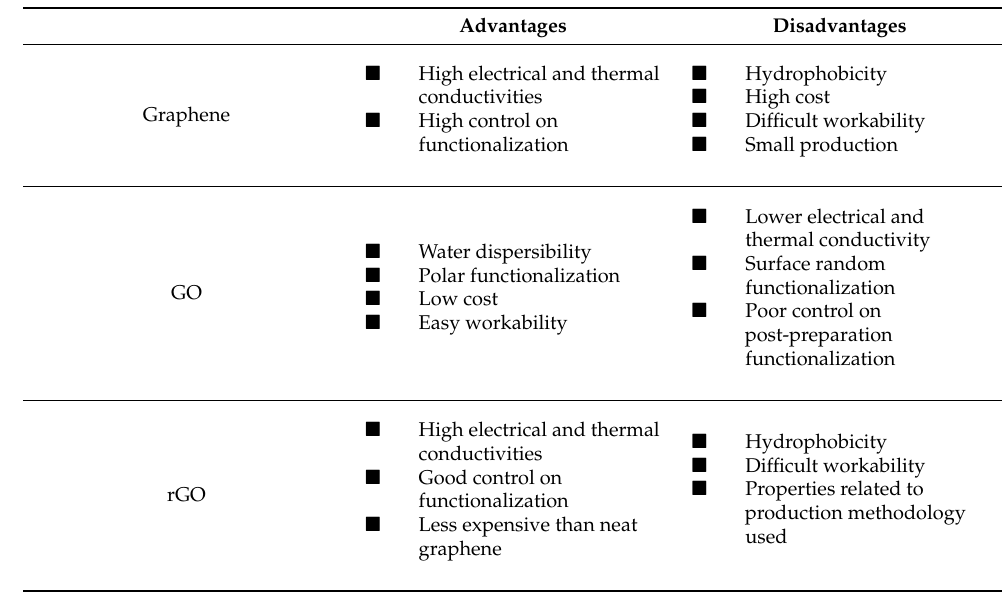
Table 1. Main advantages and disadvantages of graphene and related materials for biological